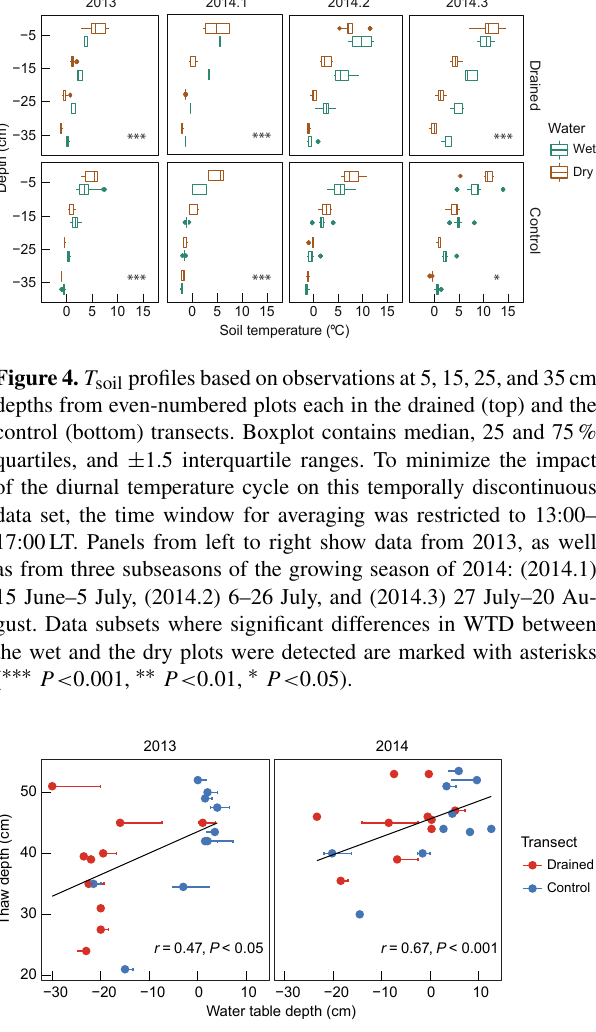
Figure 5. Correlations of TDs and WTDs in mid-August 2013 and 2014. Error bars of WTD represent the minimum and the maximum ranges of WTD of the previous 20 days. Results of correlation anal- ysis for each year are presented with black lines.